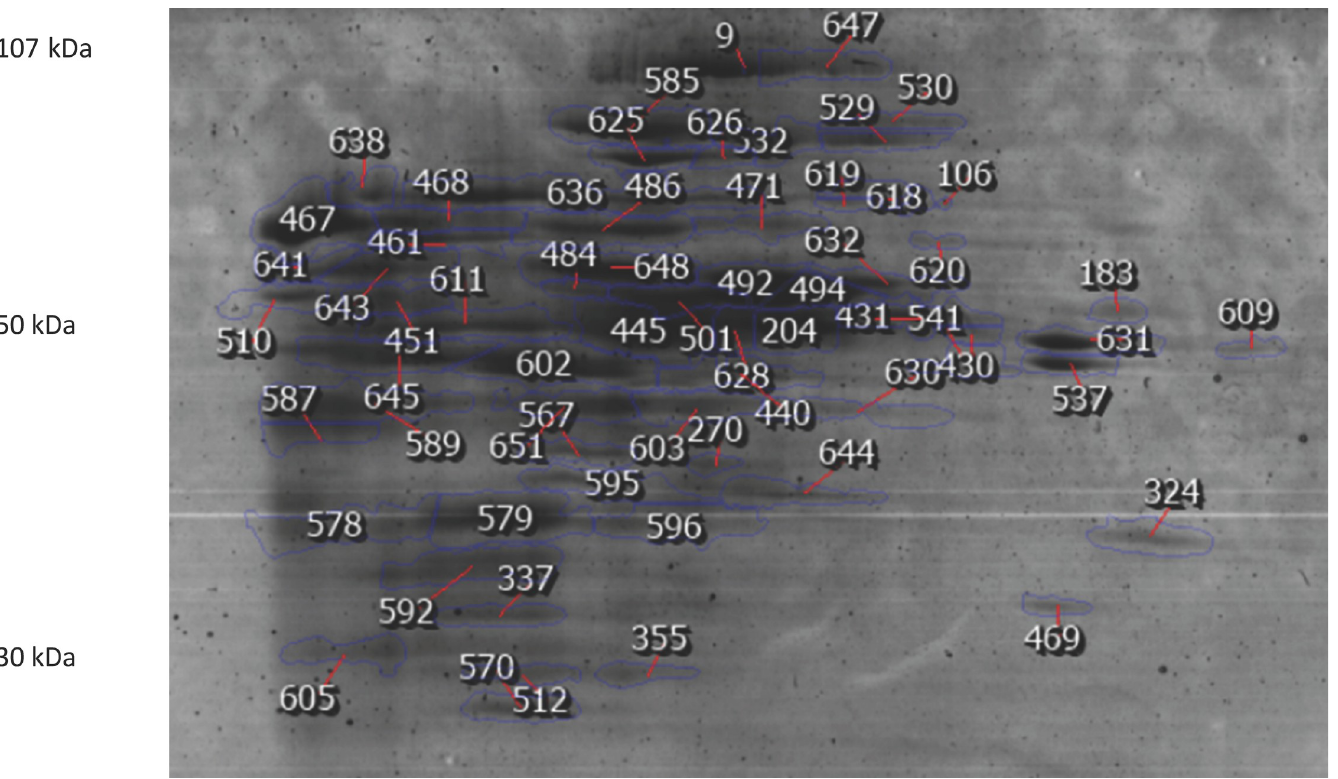
Fig 2. An example of one of the second dimension separations BN-PAGE / SDS-Page. Numbered protein spots were identified and detailed in Table 1. Proteins were stained with CCB and identified with MALDI-TOF/TOF.